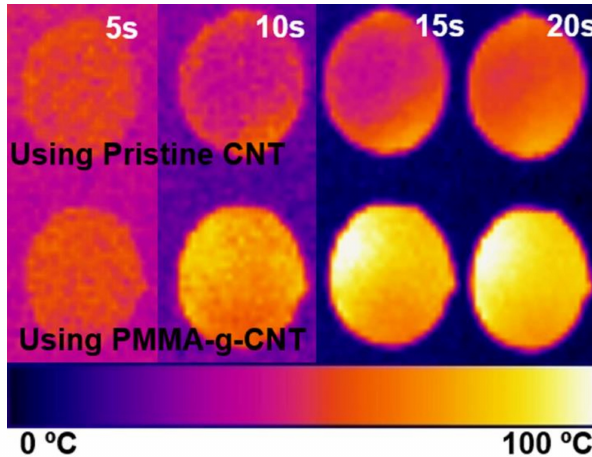
Figure 12. IR image of samples that represent the e ff ect of polymer grafting on the surface of